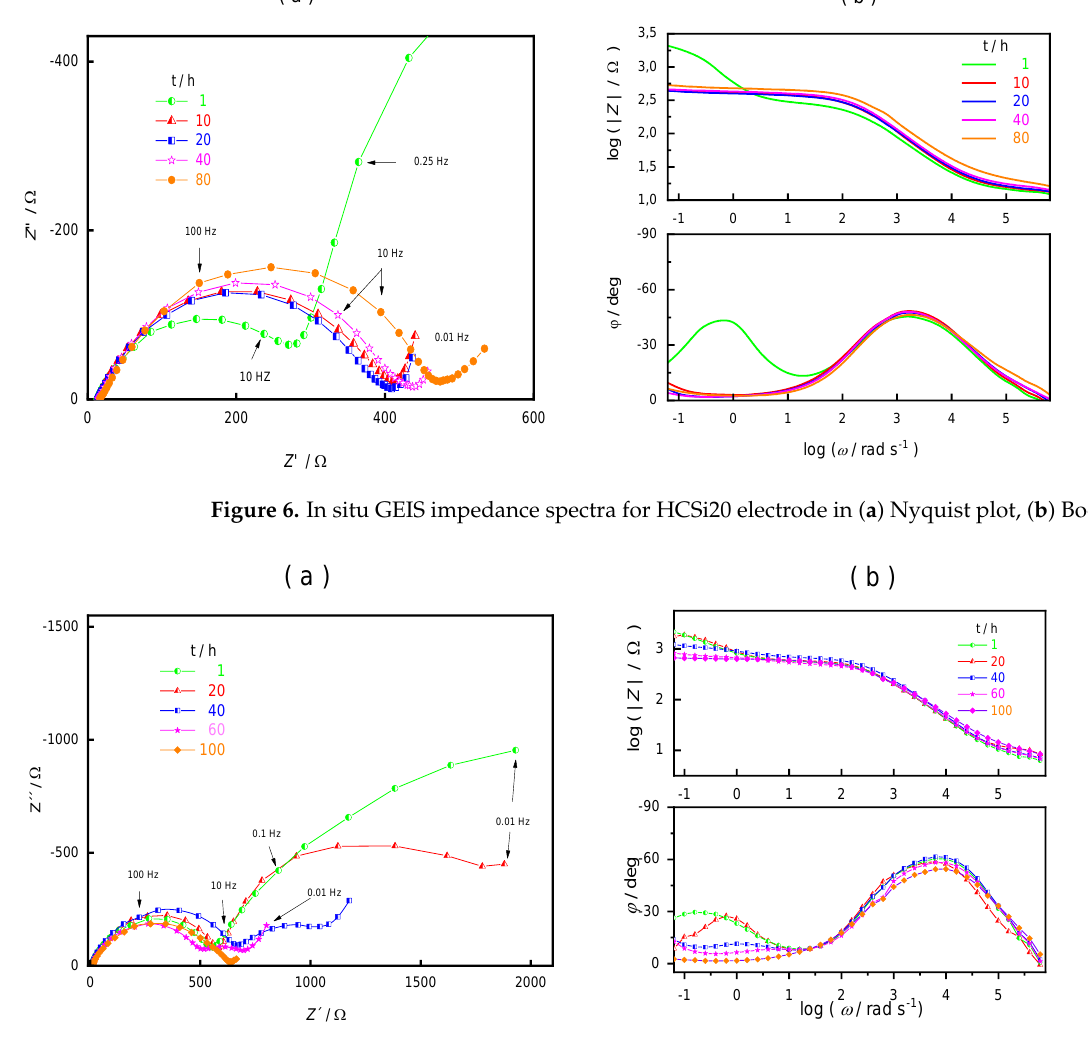
Batteries 2023 , 9 , x FOR PEER REVIEW 8 of 15